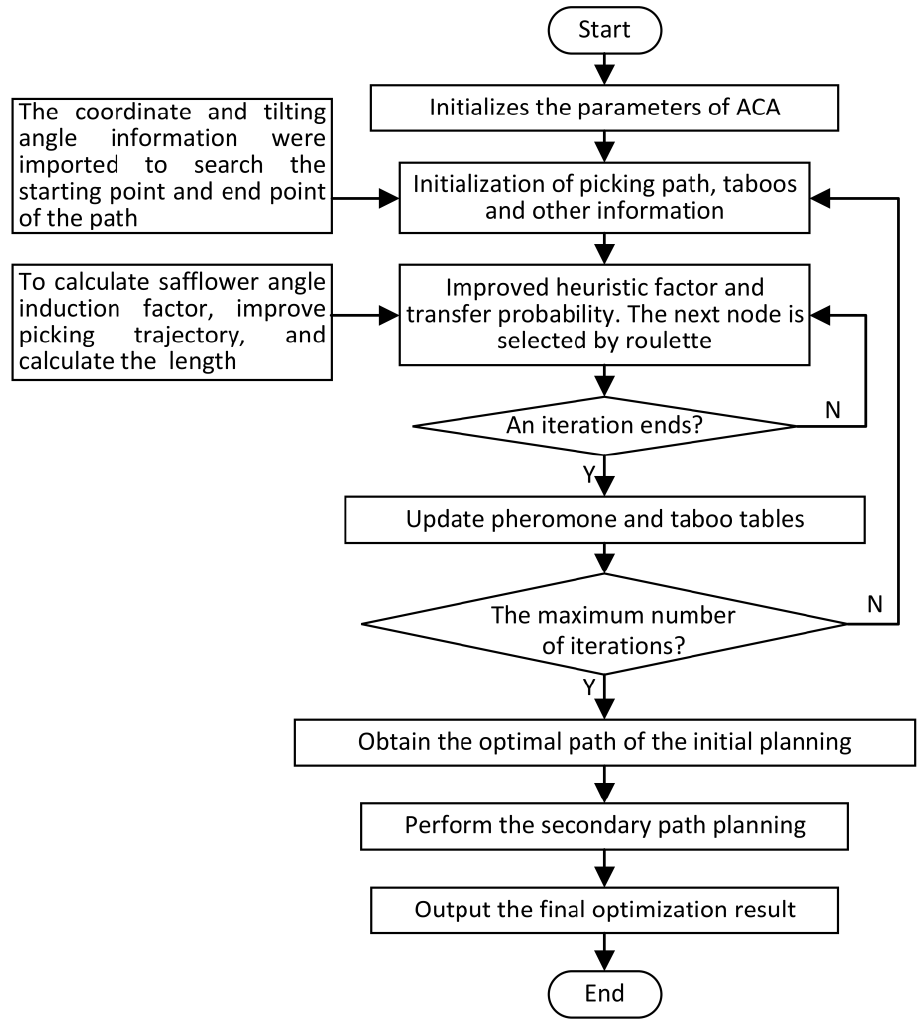
Figure 9. Flowchart of safflower picking path planning based on improved ACA.